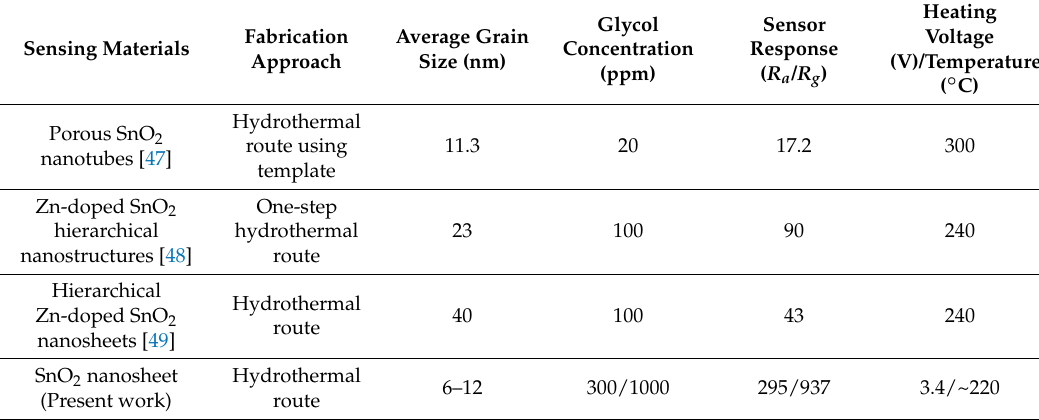
Table 1. Comparison of the sensing properties of SnO 2 nanosheets and other reported SnO 2